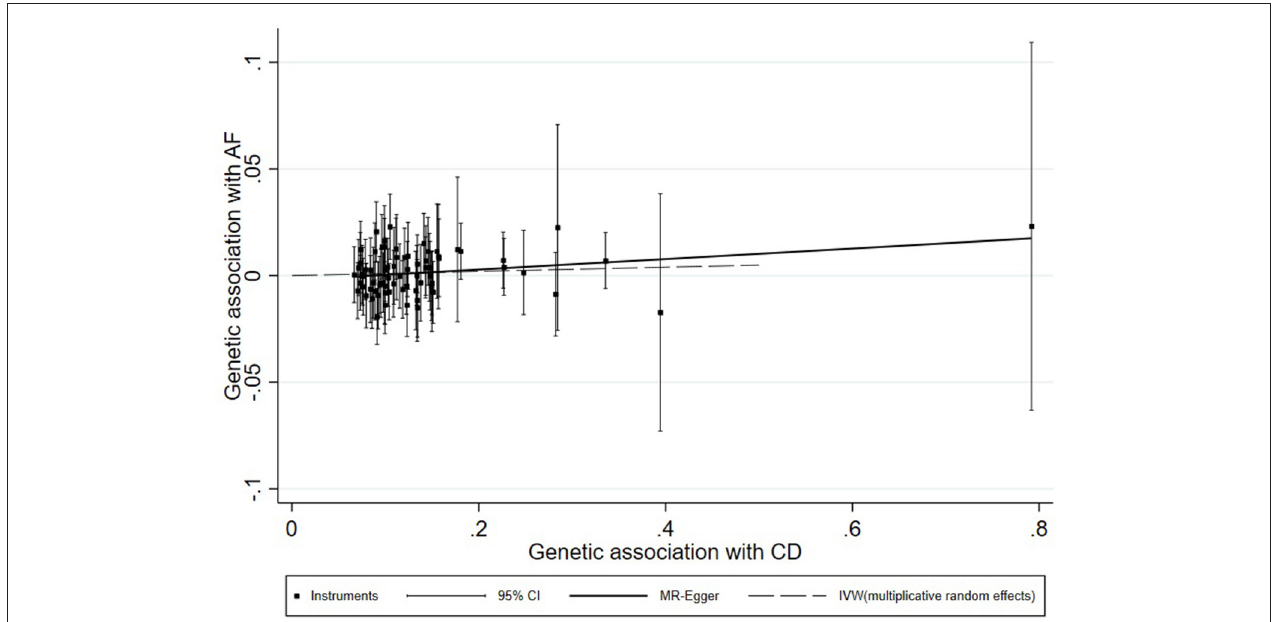
FIGURE 3 | Scatterplot of genetic associations with atrial fibrillation against associations with Crohn’s disease, with causal estimates ( β coefficients) of Crohn’s disease on atrial fibrillation estimated by weighted inverse-variance (dashed line), and MR-Egger (solid line) methods. The straight lines should be the change in the log odds of atrial fibrillation per unit increase of the log odds of Crohn’s disease.